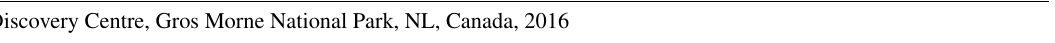
Table 2. Examples of visitor responses to exhibitions at the Discovery Centre, Gros Morne National Park, NL, Canada, and the Art Gallery of St. Albert, AB, Canada. Complete visitor responses are listed in the